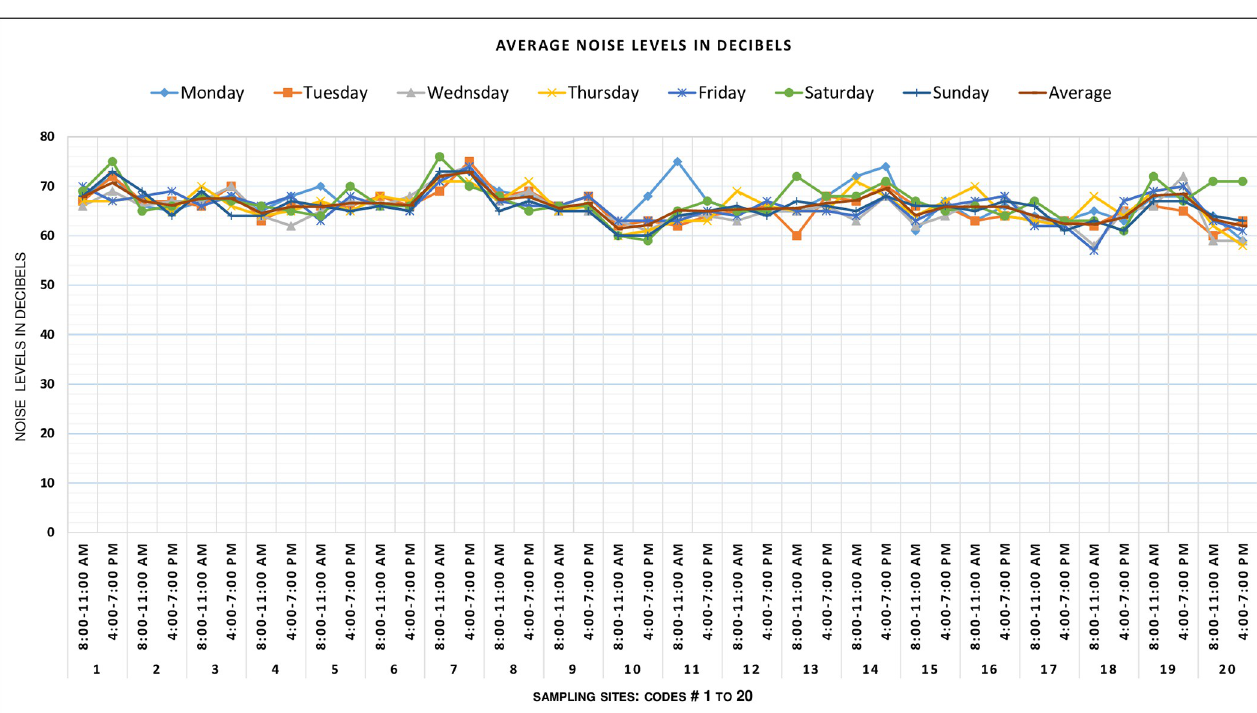
Fig 1. Daily average (morning and afternoon) and a week average road traffic noise levels in decibels in Dessie city administration, northeast Ethiopia. (Sampling sites 1: Arada 1; 2: Arada 2; 3: Gumruk; 4: Salayish; 5: Piassa; 6: Piassa to bus station; 7: Bus station; 8: Fasika Hotel; 9: Selam G. Hospital; 10: Dessie Comprehensive Specialized Hospital; 11: Ethio G. Hospital; 12: Abebech Wollo; 13: St. Gebriel Church; 14: B/Wuha Square; 15: B/Wuha Condominium; 16: Dolphin; 17: Red Cross Condominium; 18: Terminal Condominium; 19: Tequam; 20: Ersha-seble Condominium).